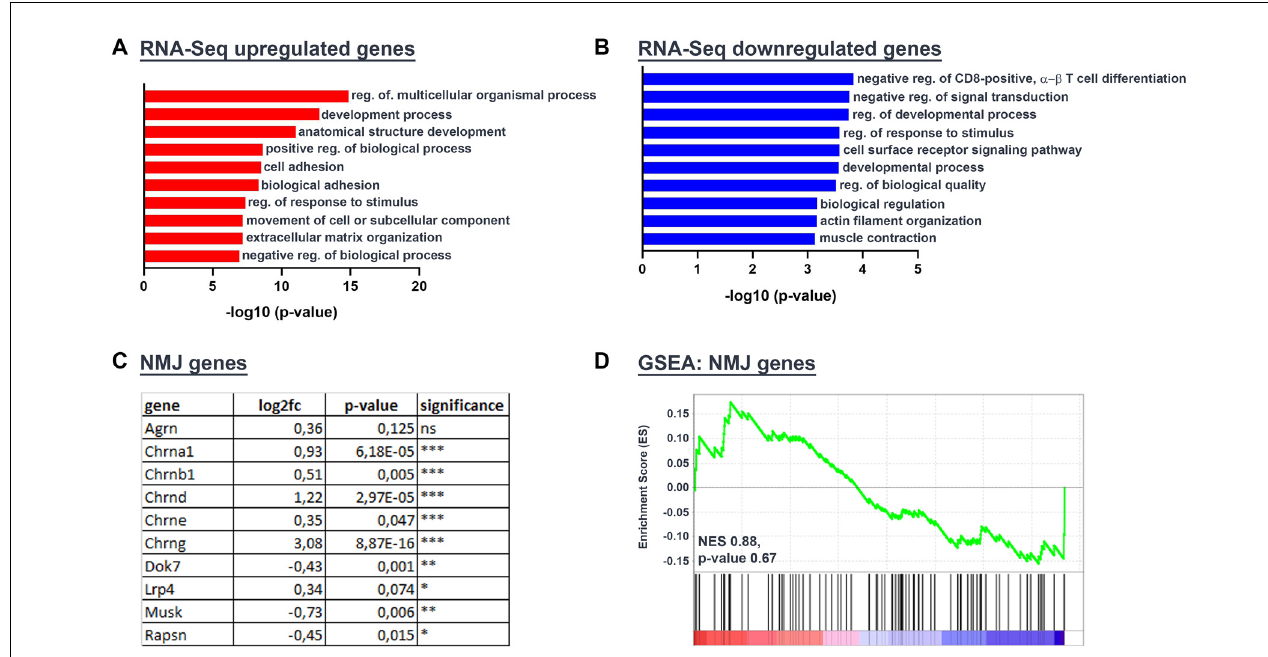
FIGURE 5 | Gene Set Enrichment Analysis of Transcriptome Data discloses a dysregulation of synaptic gene expression. RNA-Seq of five wild-types and five desmin knock-out mouse tissue specimens derived from gastrocnemius/plantaris muscles revealed several differentially regulated genes. (A,B) GO Analysis was performed with genes that were up- or downregulated at least 2-fold in desmin knock-out mice (up log2fc ≥ 1, down log2fc ≤ − 1). (C) The table depicts a set of NMJ-specific genes with their RNA-Seq expression results in the desmin knock-out genotype as compared to wild-type controls [log2fc, p -value: p ( ∗ P ≤ 0.05; ∗∗ P ≤ 0.01; ∗∗∗ P ≤ 0.001)]. (D) Gene set enrichment blot from GSEA analysis of RNA-Seq data with the NMJ gene set. Normalized enrichment score (NES) and p -value are listed at the bottom of the